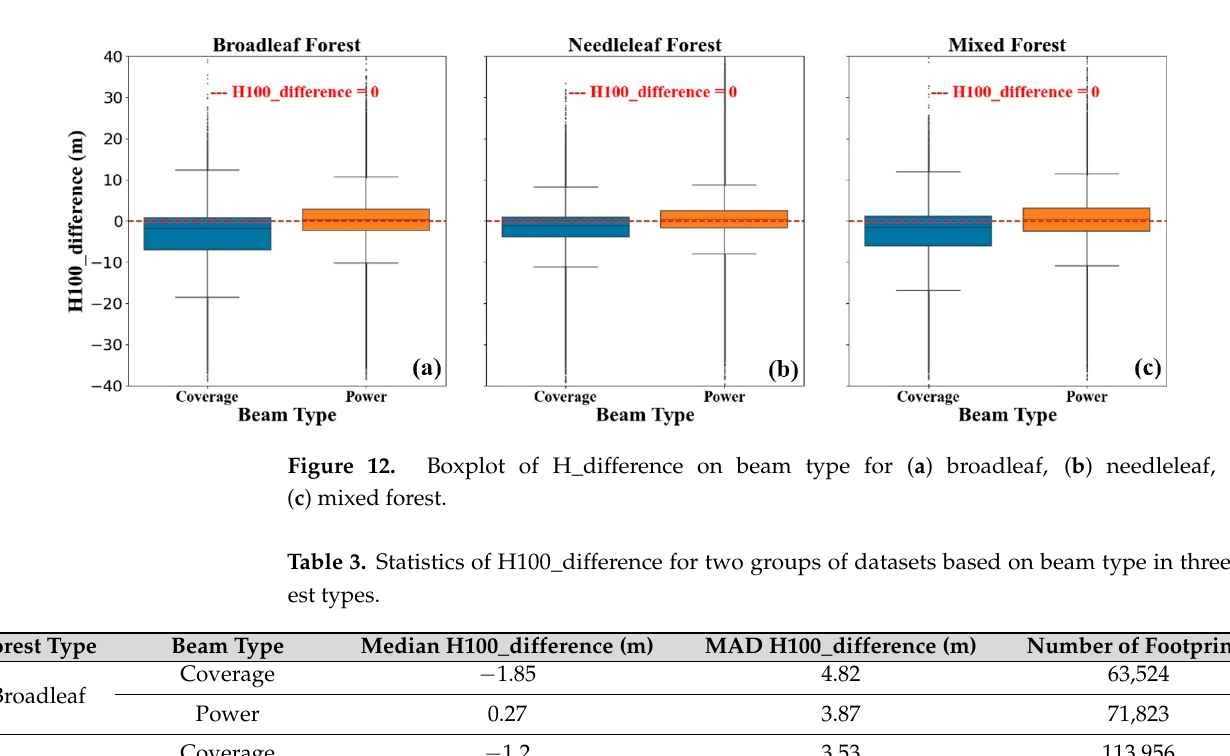
Figure 11. Boxplot of H_difference on acquisition time for ( a ) broadleaf, ( b ) needleleaf, and ( c ) mixed forest.